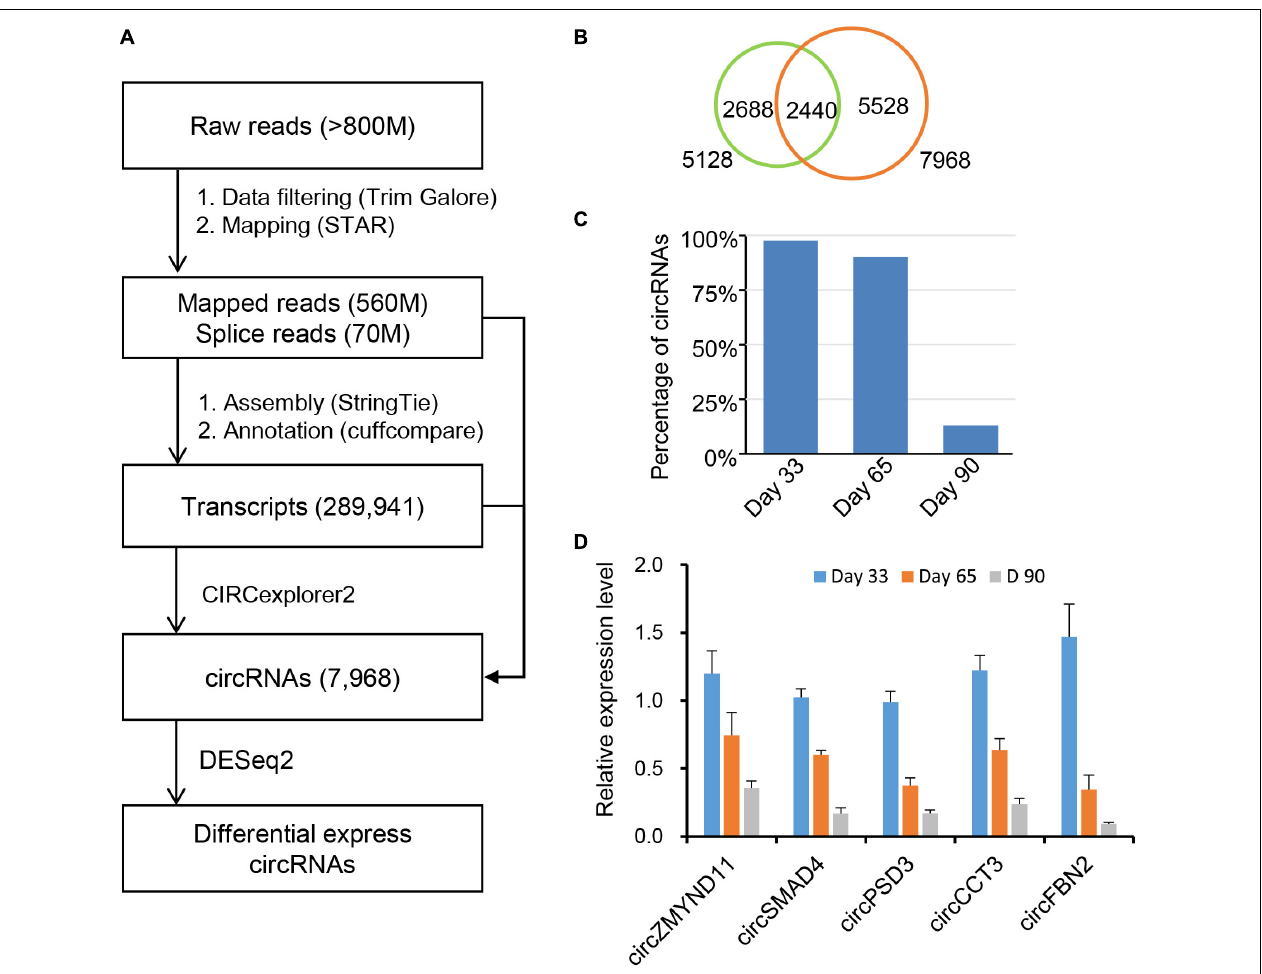
FIGURE 1 | Identification of circRNAs in skeletal muscles at embryonic development. (A) A pipeline for circRNA identification. (B) Overlapping of the newly assembled circRNAs and the reported circRNAs. (C) The distribution of circRNAs on day 33, day 65, and day 90 of gestation. (D) RT-qPCR validation of circRNAs during embryonic muscle development, results are presented as mean ± SD (three independent replicates per group).